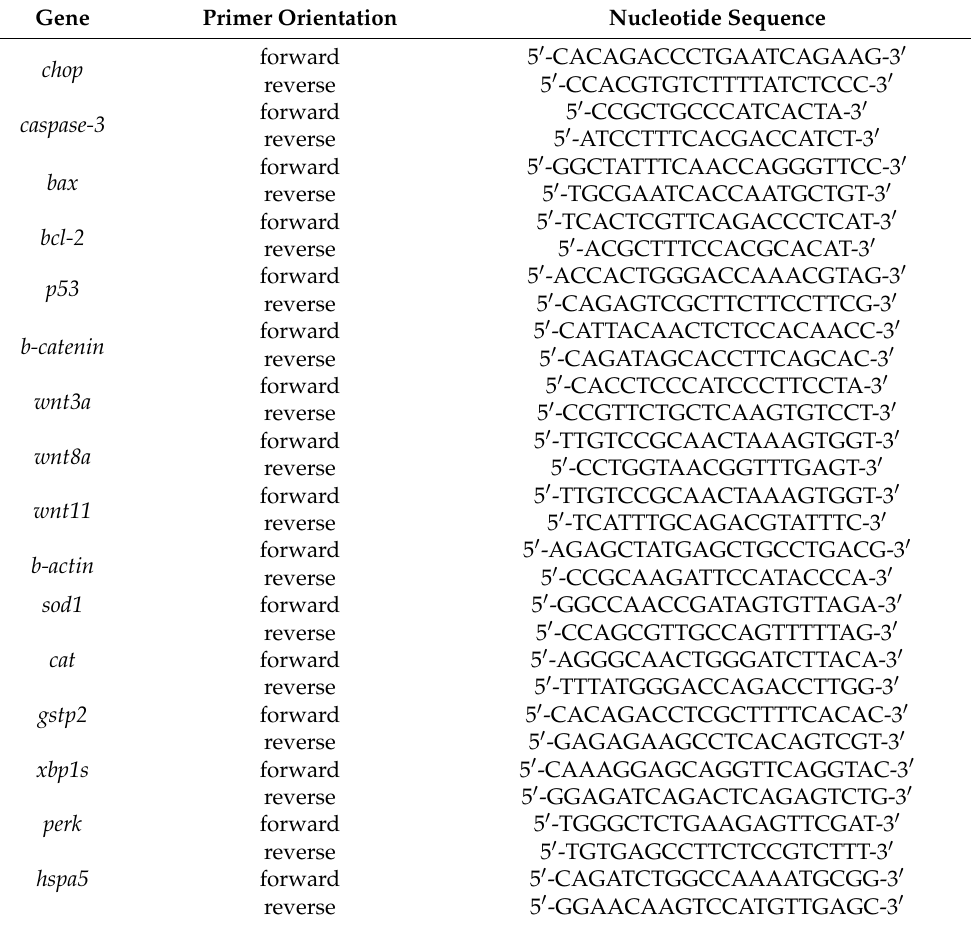
Table 1. Primers for real-time